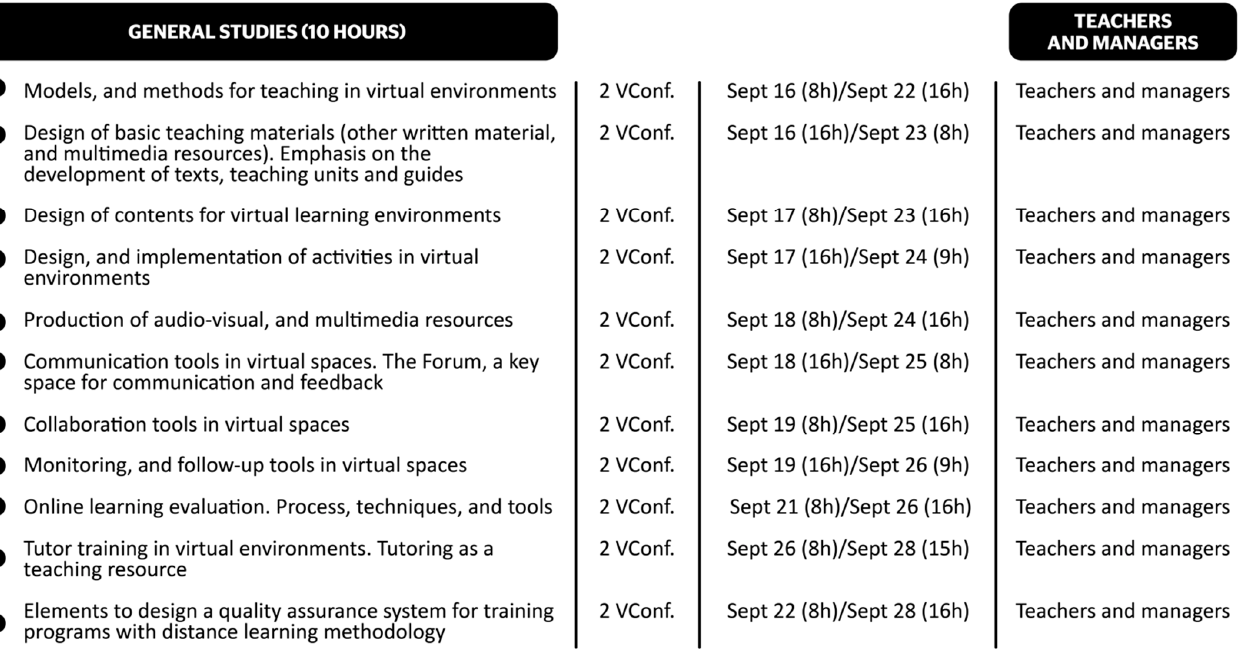
Figure 6. Initial schedule of general courses.